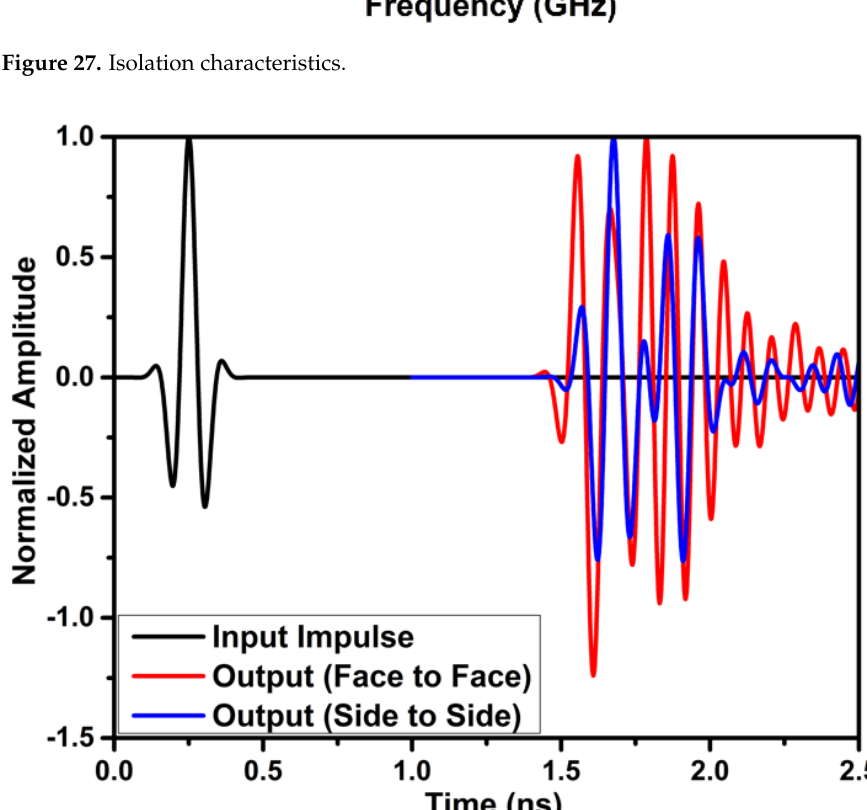
Figure 28. Fidelity factor of the UWB notch antenna.